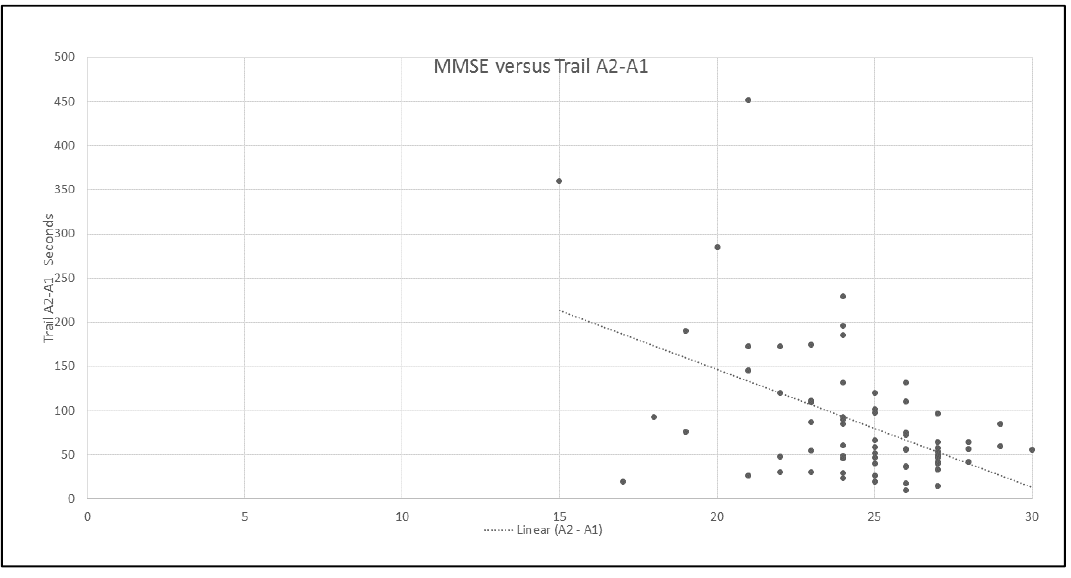
Figure 3. The Mini Mental State (MMSE) scores versus focused attention differences.